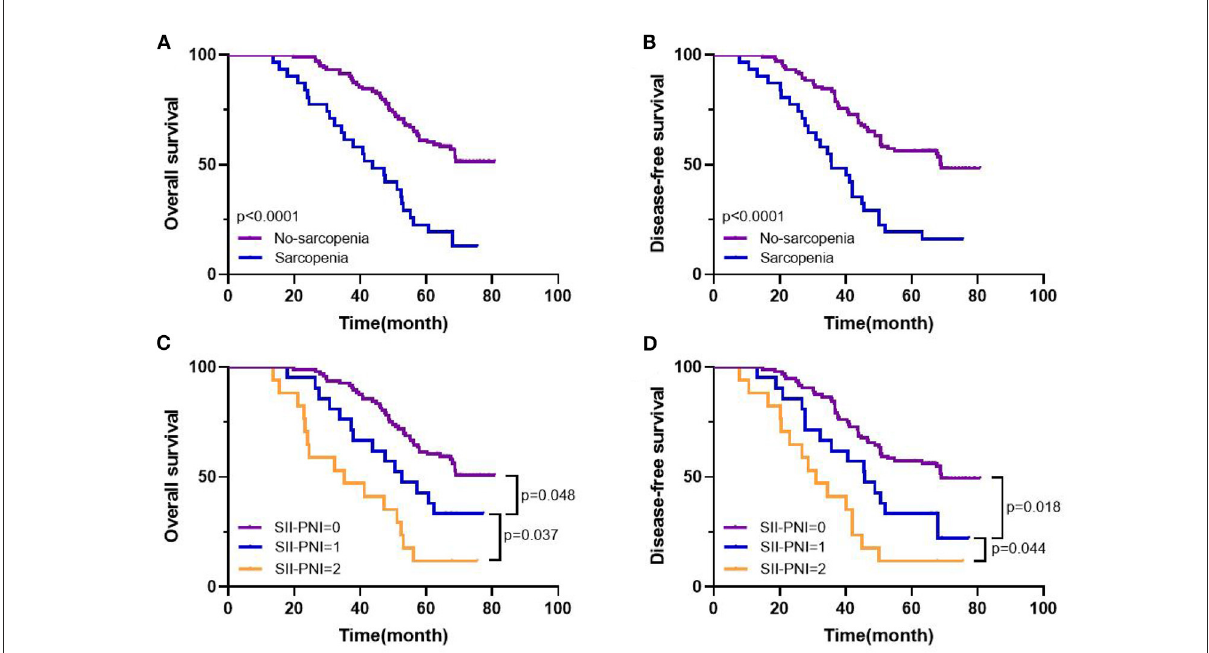
FIGURE6 Kaplan-Meier survival curves in patients with LAGC. 5-year overall survival (A) , disease-free survival (B) based on sarcopenia status; 5-year overall survival (C) , disease-free survival (D) based on SII-PNI score.